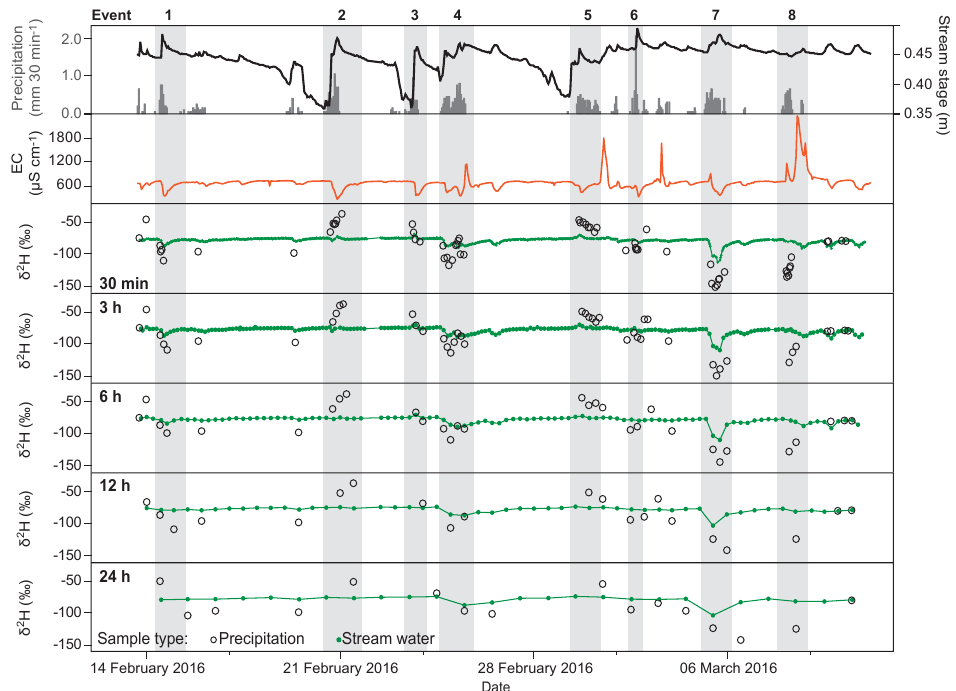
Figure 10. Time series of precipitation, stream stage, and stream water EC, as well as δ 2 H values in stream water and precipitation at sampling intervals of 30min and 3, 6, 12, and 24h. The stream water isotope values at 3–24h temporal resolution were obtained by subsampling from the 30min time series. To mimic the effects of integrated bulk precipitation samples, the isotope values in precipitation were calculated by volume-weighted averaging the 30min data over the corresponding time intervals. The vertical grey bars indicate the periods of the eight precipitation events used for hydrograph